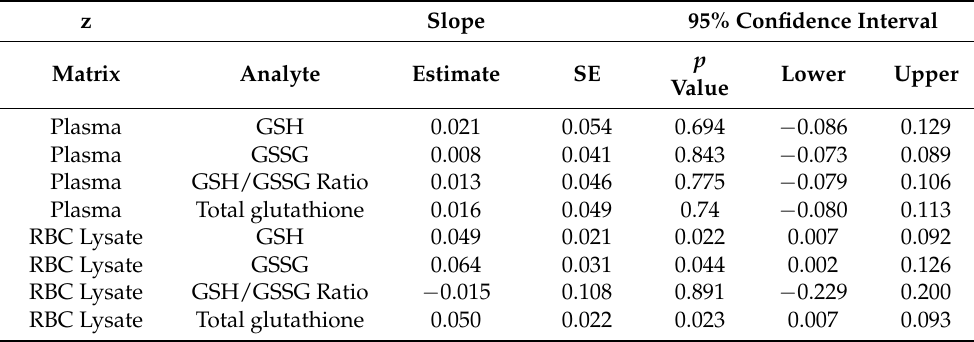
Table 6. a-LA intake (in mg/kg body weight/day) and glutathione levels (in ng/mL) in plasma and RBC Lysates at Month 6 vs.